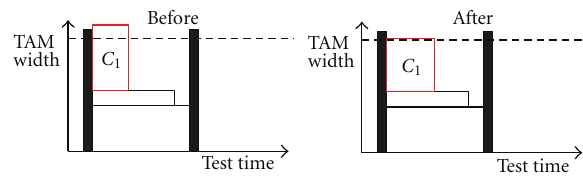
Figure 7: Resize